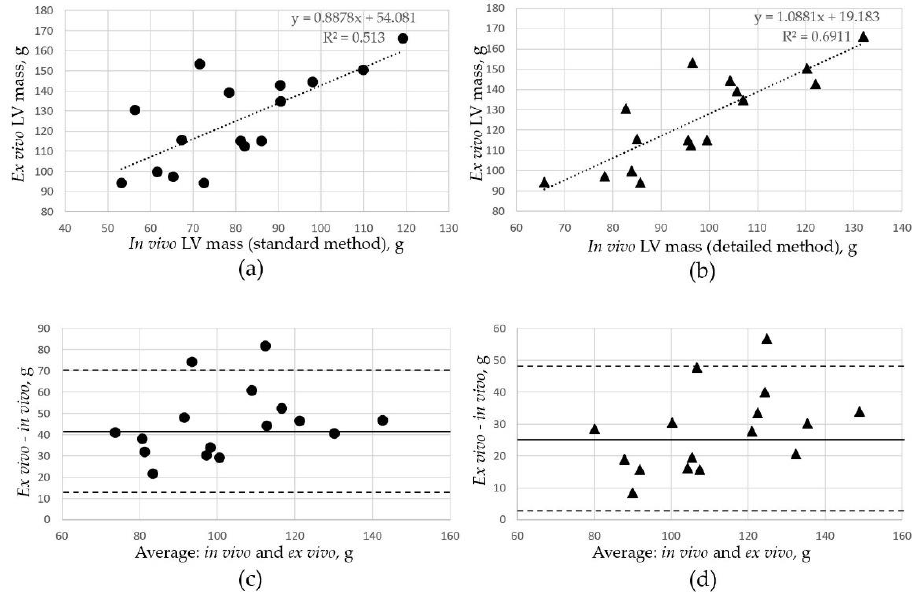
Figure 4. Comparison of LV mass estimation with in vivo MRI and ex vivo after heart